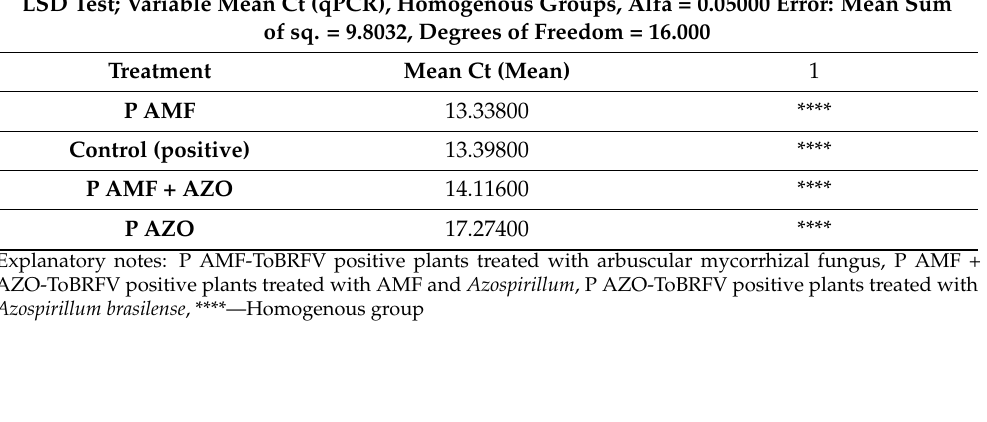
Table 3. Results of Fisher’s LSD test of mean Ct of qPCR assay detecting ToBRFV virus.